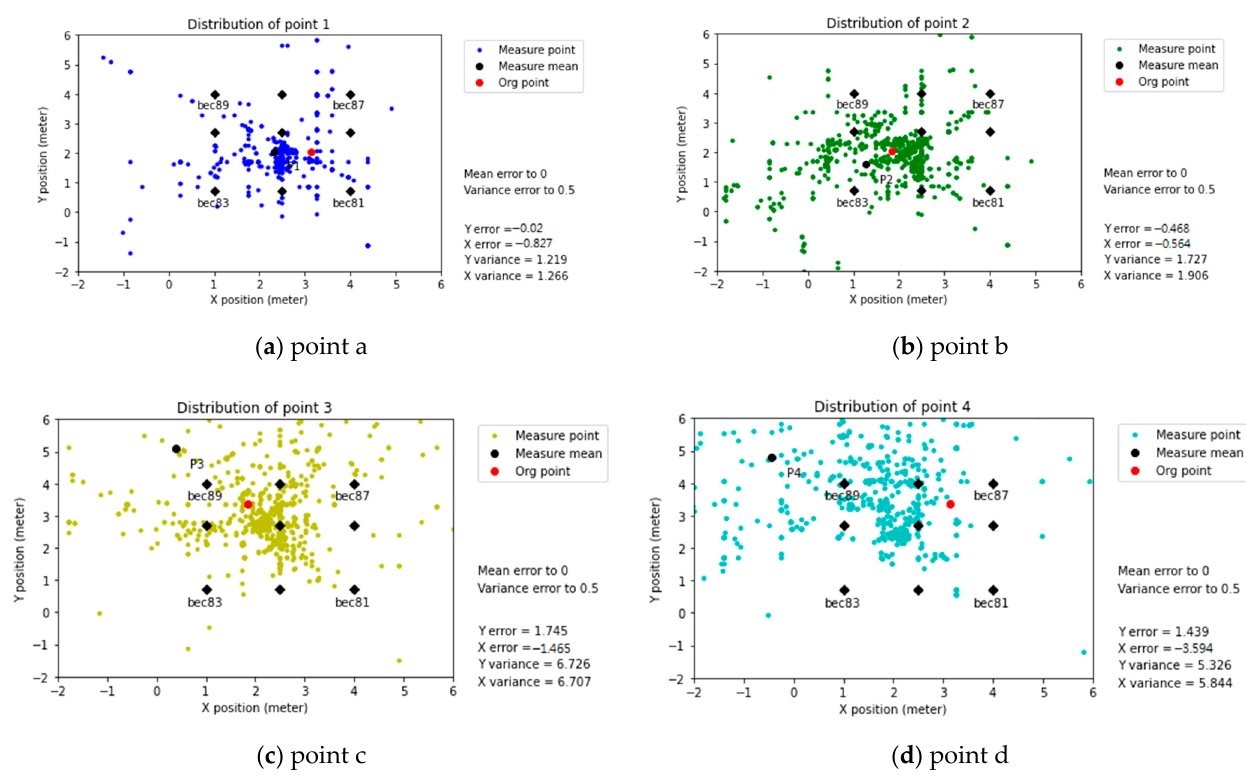
Figure 19. Predicted positioning (without modification coefficients), BLE 4.2 (Linkit7697).